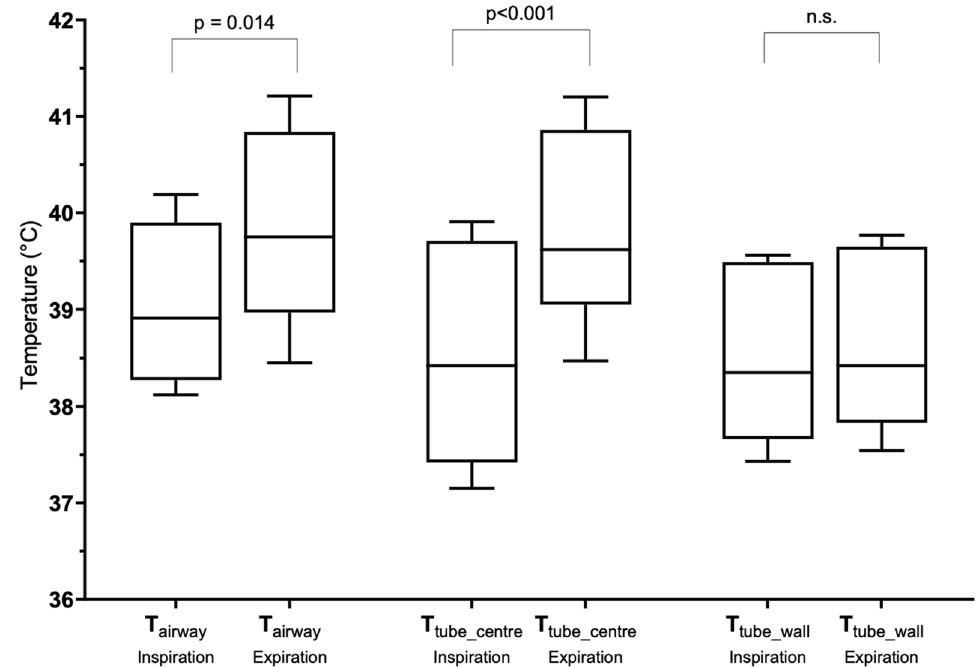
Figure 2. Temperature values recorded at three different locations. T airway and T tube_centre were relatively higher for the expiratory phase than for the inspiratory phase. Symbols: box, first and third quartiles; bold line, median; perpendicular line, range. T airway airway temperature; T tube_centre temperature at the centre of the endotracheal tube; and T tube_wall temperature at the wall surface of the endotracheal tube.